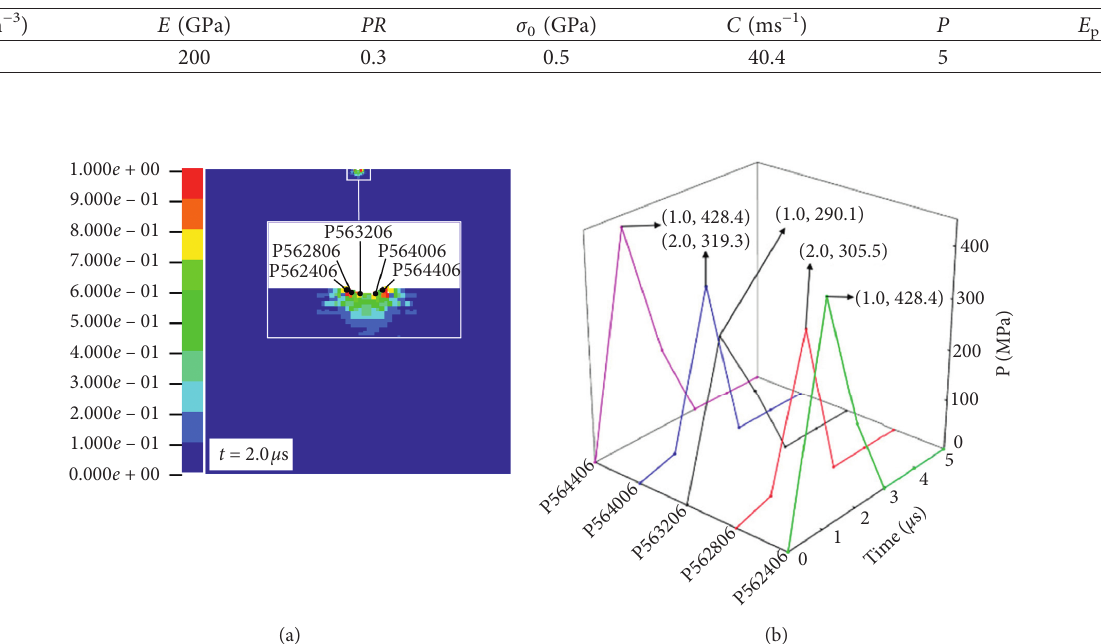
Figure 2: Crater formation of SFRC. (a) Appearance of crater. (b) Pressure curves of typical particles in solid-liquid contact